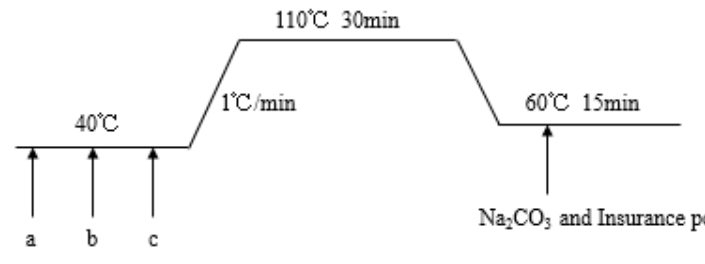
Figure 3. Dyeing flow chart of warp-knitted fabrics.